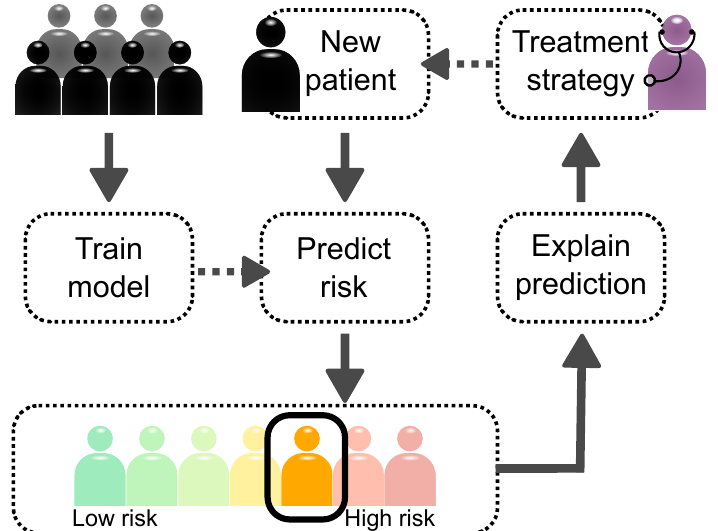
Figure 3. A typical clinical decision system with explainable AI. An AI model is first trained on a cohort containing for example clinical, imaging or multi-omics data. The trained model is then used to predict the risk for a patient to develop the disease or specific symptoms. Finally, the explainable AI provides information about the decision patterns, which helps the medical practitioner to assess faithfulness of the prediction and formulate a treatment